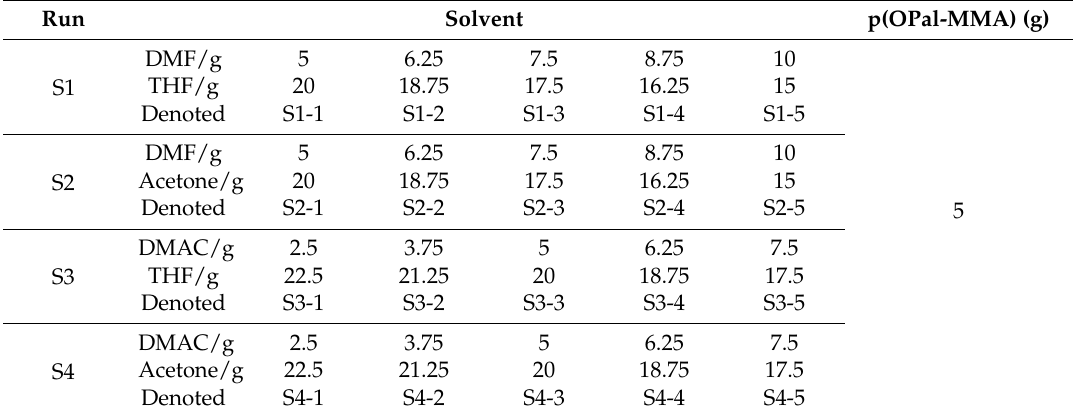
Table 1. The amount of solvents and polymers for preparation of p(OPal-MMA) polymer